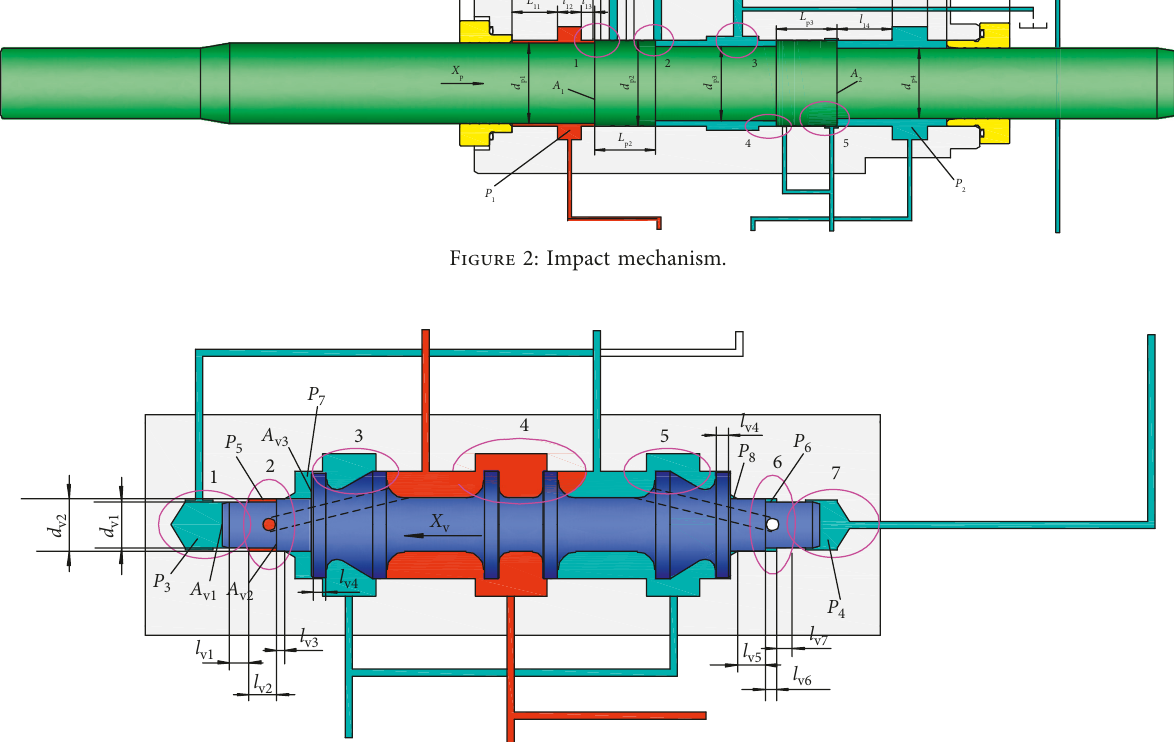
Figure 3: Reversing mechanism